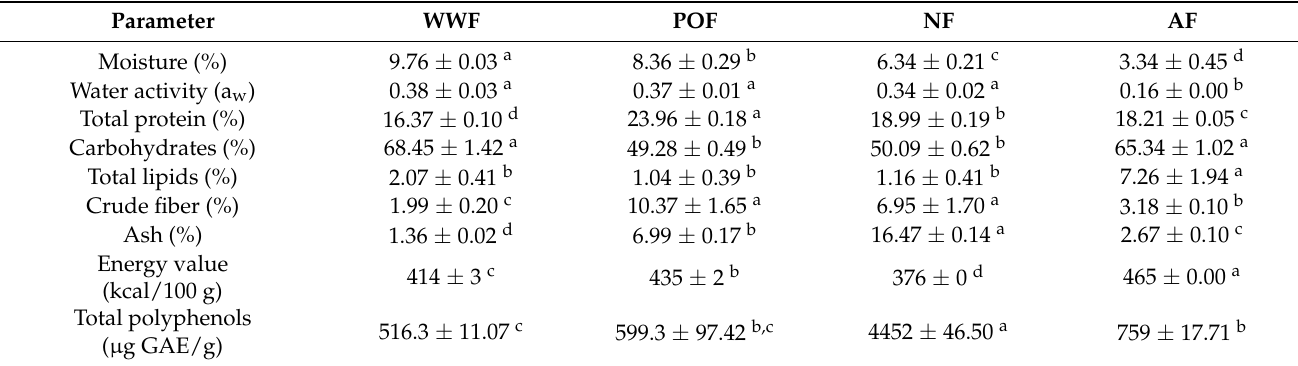
Table 2. Proximal composition, energy value, phenolic and flavonoid contents, and antioxidant activity of WWF and the three alternative flours obtained from functional ingredients used in cookie